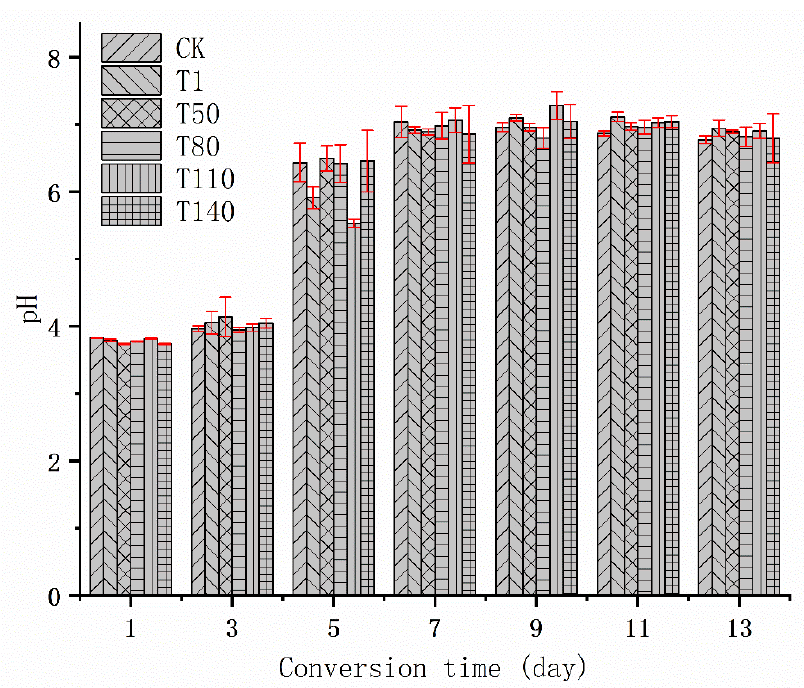
Figure 4. Effect of adding DKW on the pH variation trend of KWTR. Table 5. Effect of adding DKW on the content of nutrients in BR.